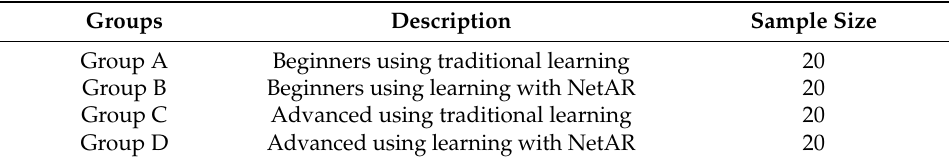
Table 6. Groups according to independent variables.